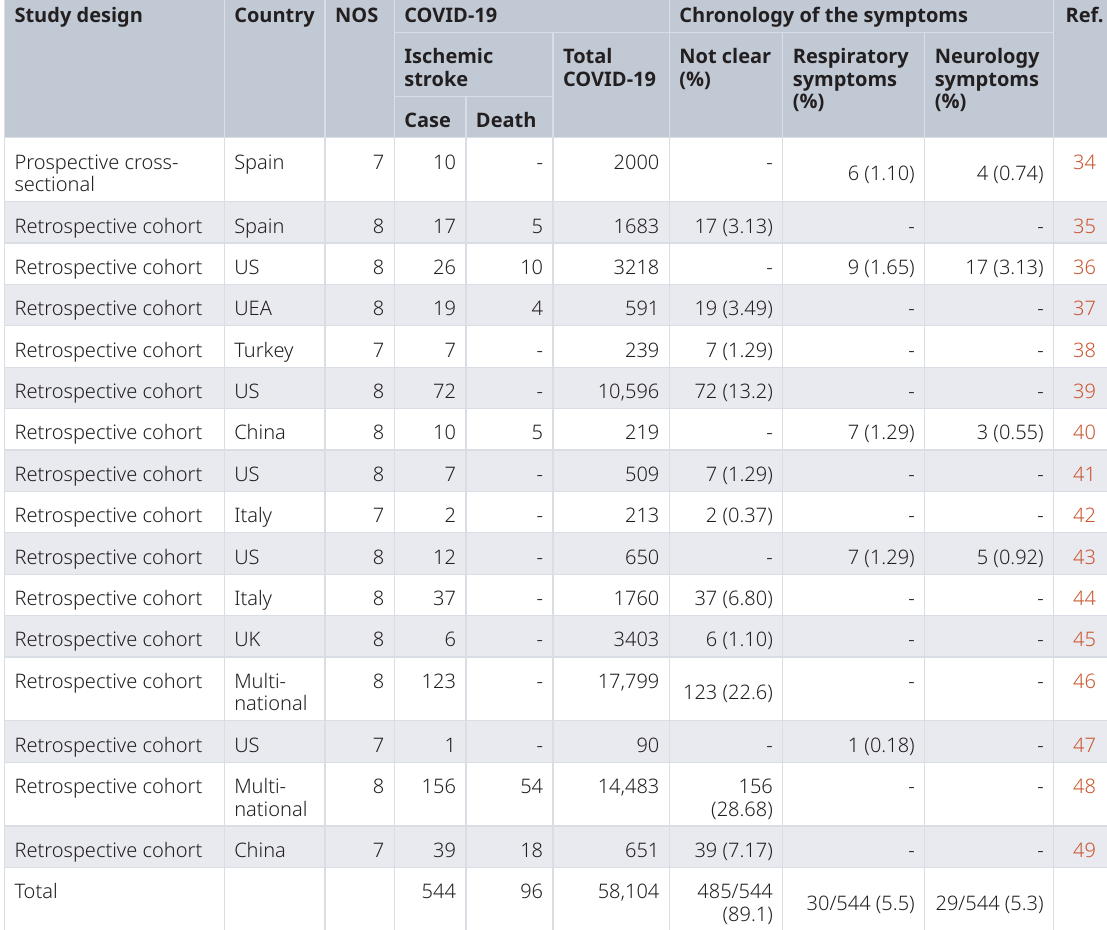
Table 2. The prevalence of ischemic stroke among COVID-19 patients around the globe. Study